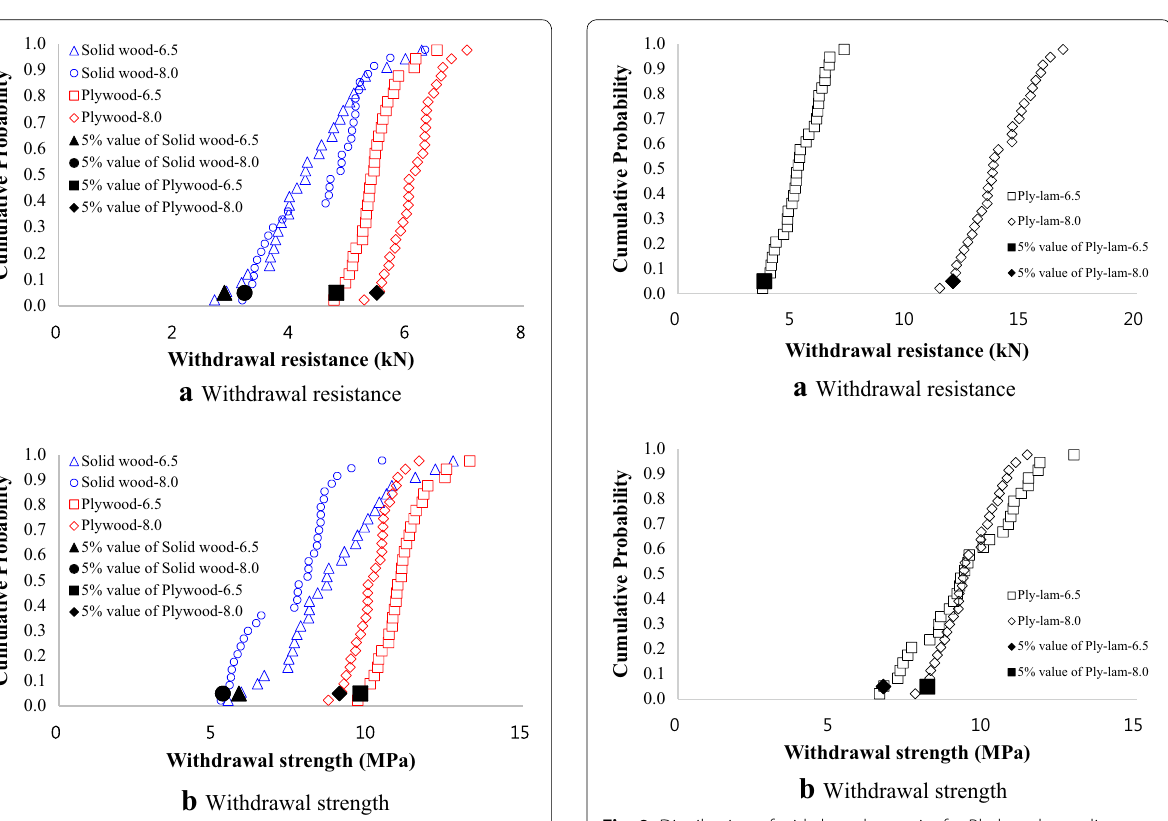
Fig. 8 Distribution of withdrawal capacity for lamina depending on the diameter of screws